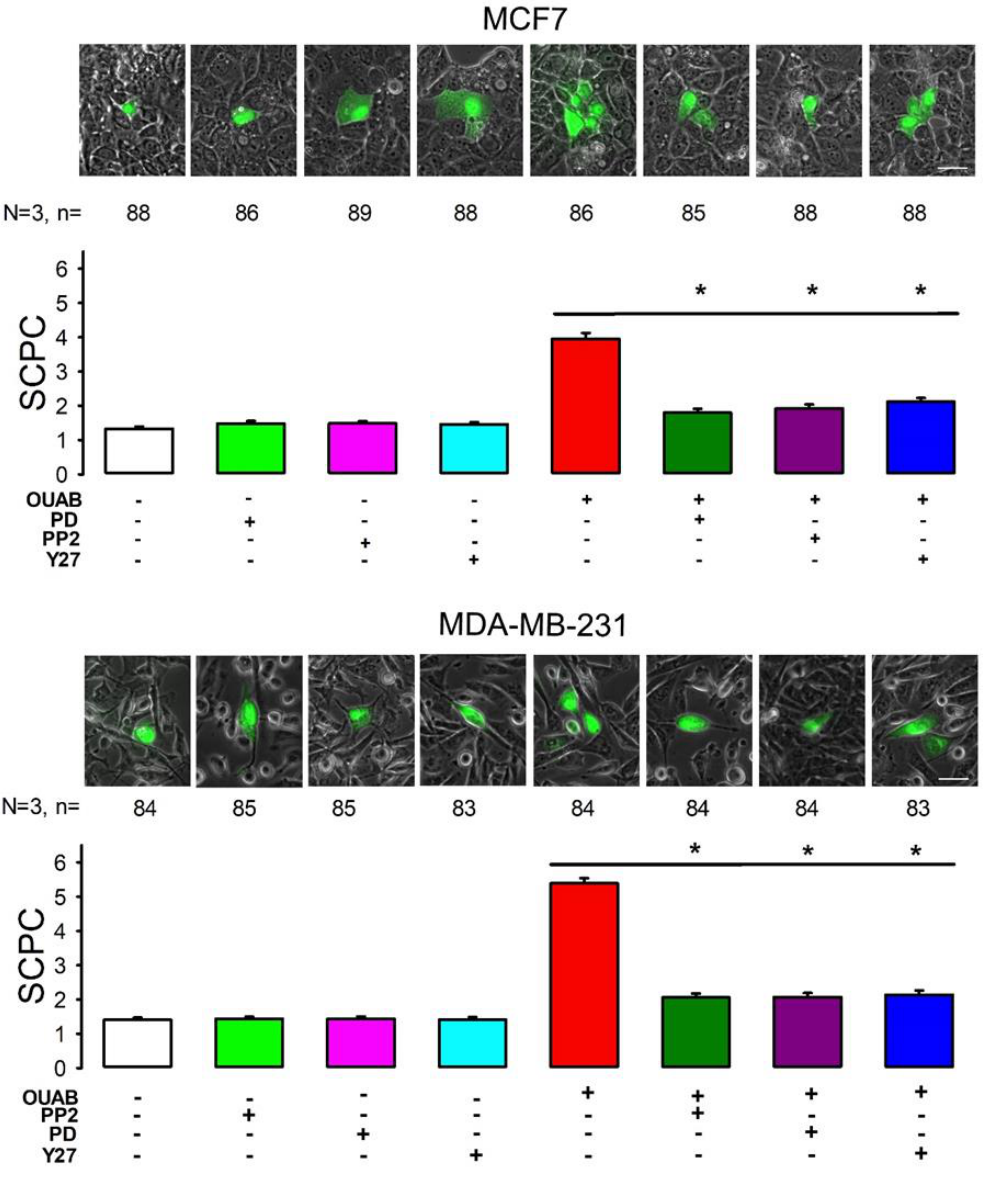
Figure 6. Involvement of c-Src, ERK1/2 and Rho-ROCK on ouabain induced GJIC enhancement. Each set shown, in the upper part, represents images of each experimental condition. The lower bar chart compares mSCPC ( ± SE) of each experimental condition indicated at the bottom of each bar. Asterisks indicate a statistically significant difference compared to the ouabain group, (Dunn’s method), * indicates p < 0.05. Scale bar length = 50 µM.